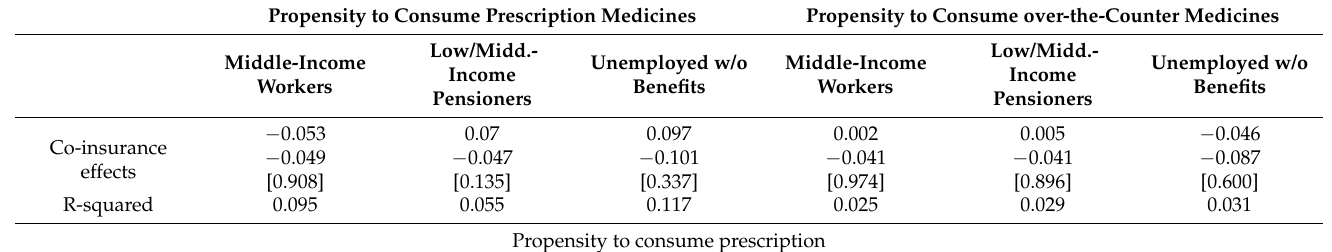
Table A4. Before-and-after